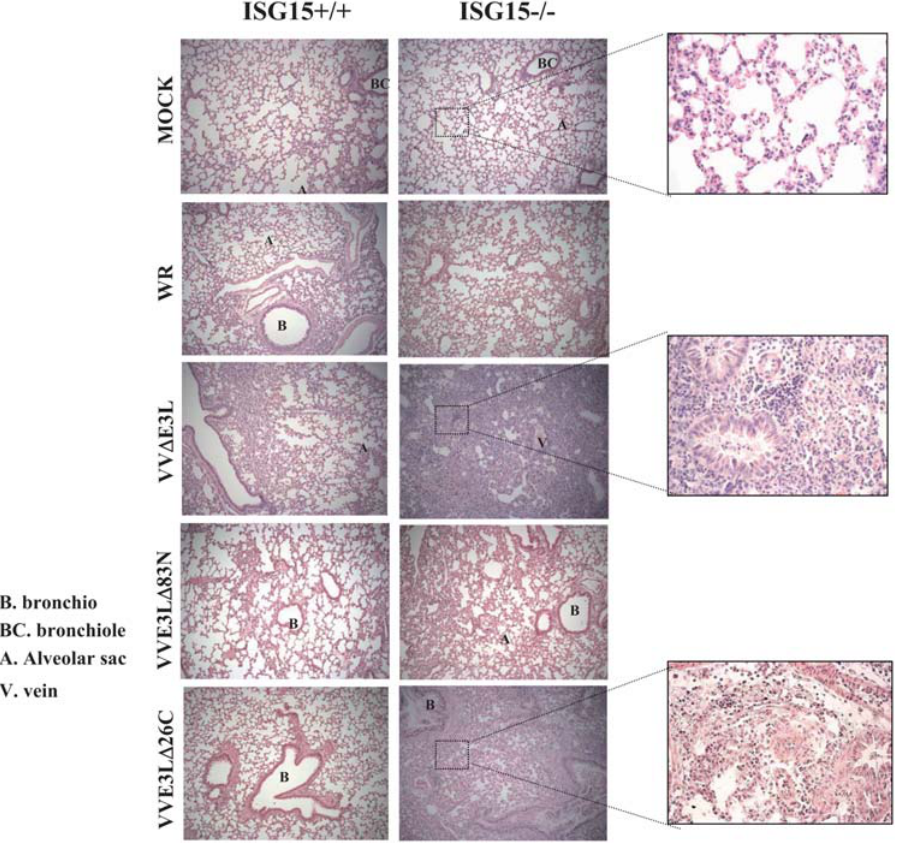
Figure 10. Histopathology of lungs from ISG15 + / + and ISG15 2 / 2 mice intranasally infected with VACV mutant viruses. Lungs from ISG15 + / + and ISG15 2 / 2 mice i.n inoculated with, WR (5 6 10 6 PFU/mouse) or MVA (5 6 10 7 PFU/mouse) or VV D E3L (5 6 10 7 PFU/mouse) or VVE3L D 83N (5 6 10 7 PFU/mouse) or VVE3L D 26C (5 6 10 7 PFU/mouse) were resected, sectioned and stained with hematoxilin and eosin. For each group of animals representative fields are shown at a magnification of 40 6 (left panels) and 100 6 (right panels). B. Bronchio, BC. Bronchiole, A. Alveolar sac, V. Vein.